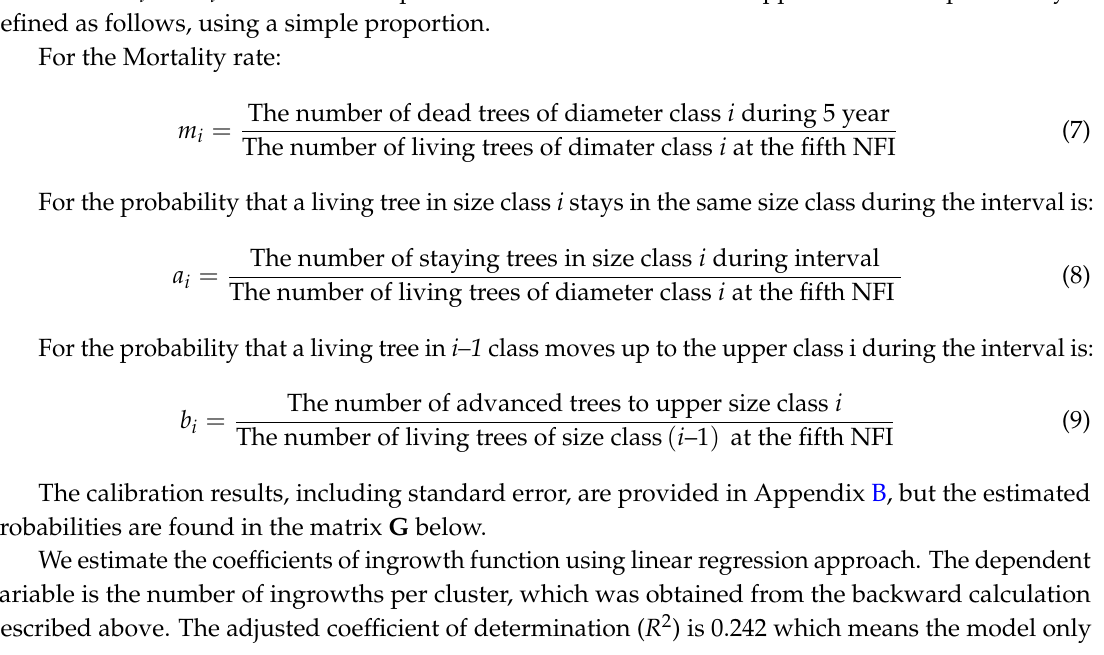
Table 2. Changes in diameter distribution between two inventories. Diameter Class (cm)